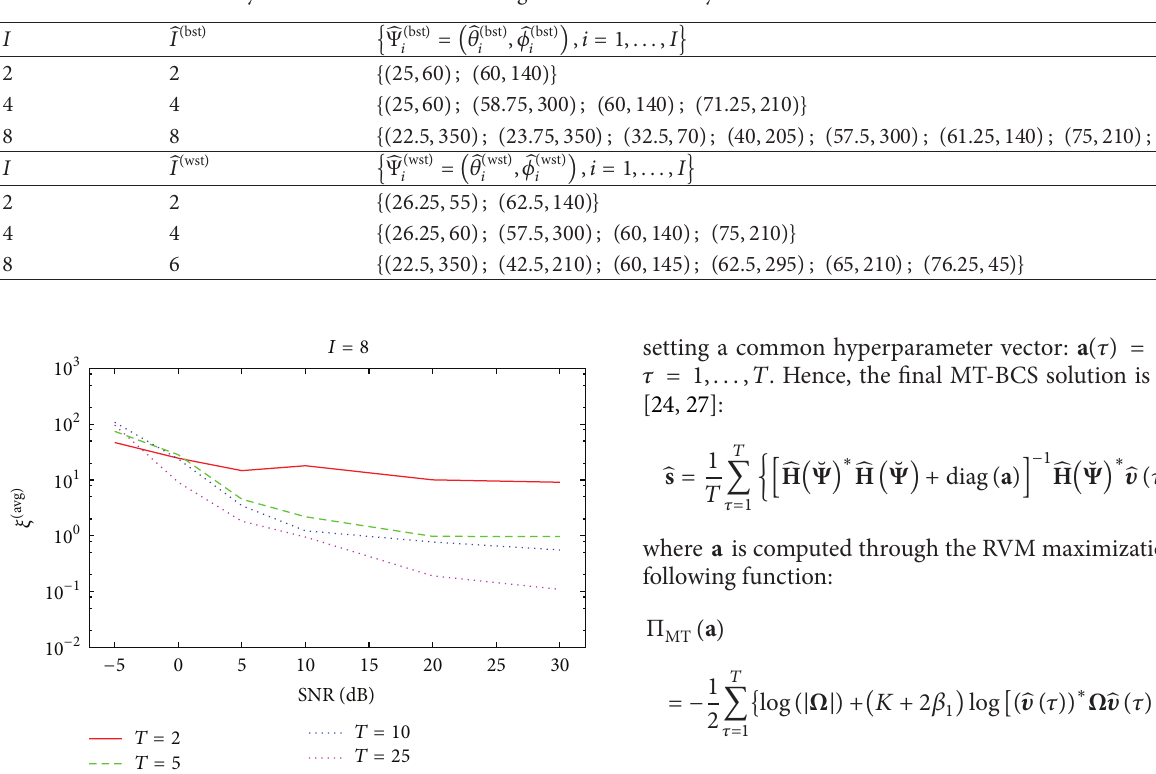
Table 4: Fully populated array—( 𝑁 = 25 ; 𝑑 𝑥 = 𝑑 𝑦 = 0.5𝜆 ; 𝐼 ∈ [2 : 8] ; SNR = 10 dB; 𝑇 = 2 ; 𝐶 = 50 )—values of the DoAs for the best and worst estimation obtained by means of the MT-BCS among the 𝐶 different noisy scenarios.